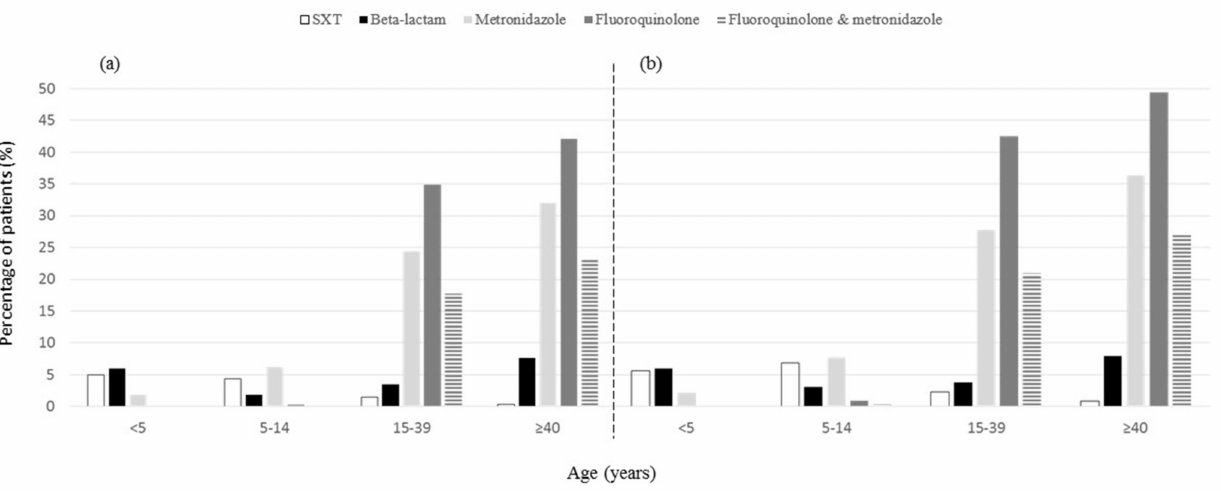
Figure 2. Percentage of patients treated with antimicrobials during the first 7 days of diarrhea caused by STEC O157, by age quartile and antimicrobial class. Panel ( a ) displays antimicrobial treatment documented in medical records. Panel ( b ) displays antimicrobial treatment documented in medical records or reported by the patient (or parent/guardian). Data on macrolides is not shown because only 20 patients received macrolides (documented among 12 (0.9%), reported among 8 (0.6%) more); documented macrolide exposure was greatest among children < 5 years old (1.3%) and lowest among adults ≥ 40 years old (0.3%). Abbreviation: SXT,